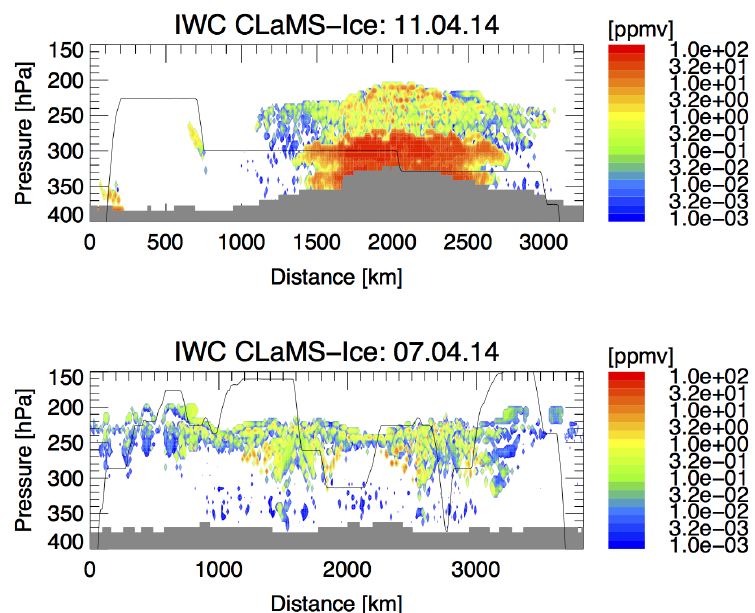
Figure 4. Examples of CLaMS-Ice simulations from ML-CIRRUS showing a liquid origin cloud sample (top) from the 11 April flight and an in situ origin sample (bottom) from the 7 April flight. The flight path is illustrated by the black line and represents the pressure at which the aircraft was flying ( y axis) and the distance since take-off ( x axis). The colors in each plot represent the simulated IWC (orange: high IWC, blue: low IWC). Grey areas indicate T > 238K and do not contain simulated clouds.